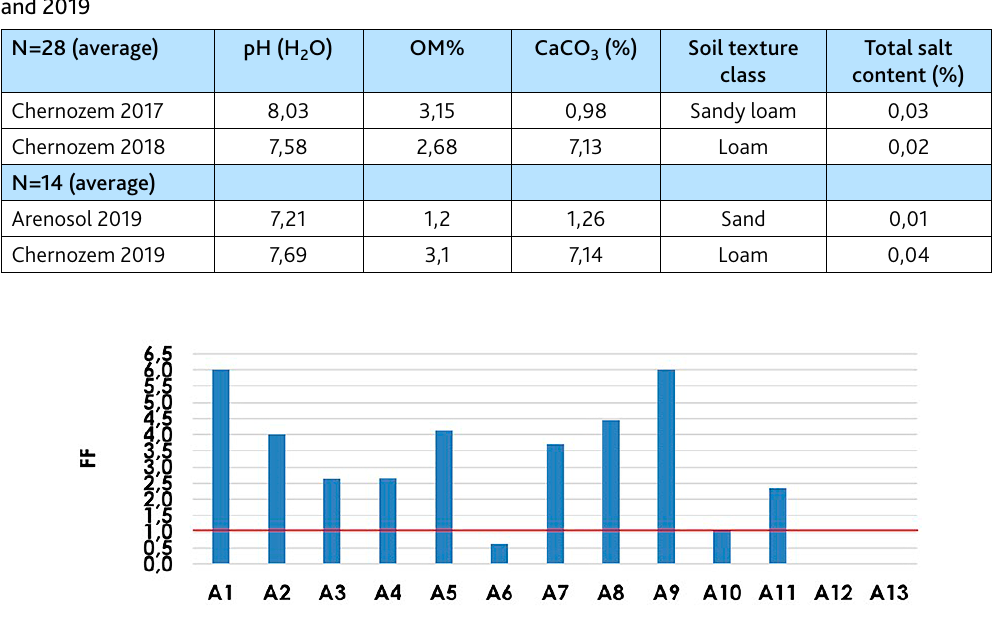
Table 1. Soil properties of the soil (Chernozem and sandy Arenolols) used in this study of 2017,2018